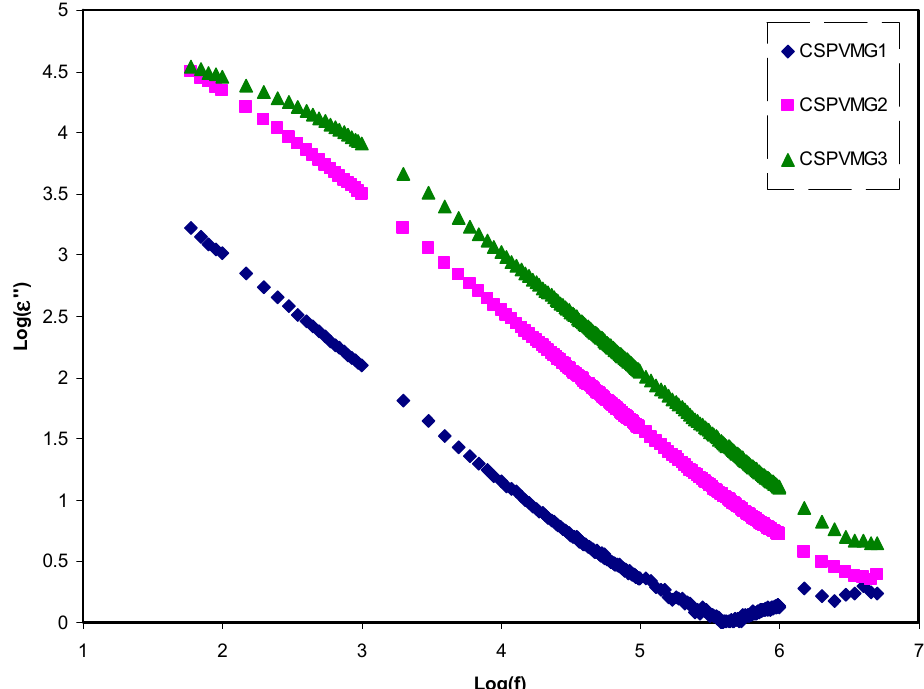
Figure 3. Variation of logarithm dielectric loss ( ε″ ) versus frequency for the CSPVMG1, CSPVMG2, and CSPVMG3 electrolyte samples at ambient temperature.